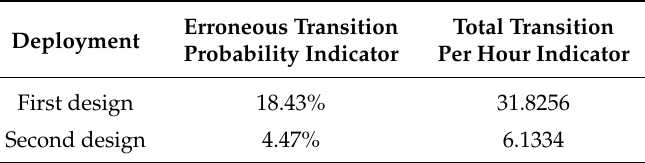
Table 3. Comparison of applied evaluation